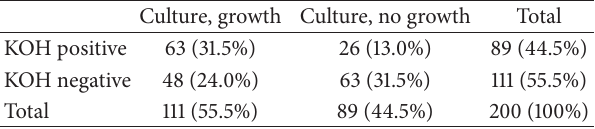
Figure 4: Macroscopic View of T. rubrum (reverse view). Table 1: Comparison of KOH mount with fungal culture ( 𝑁 = 200 ).